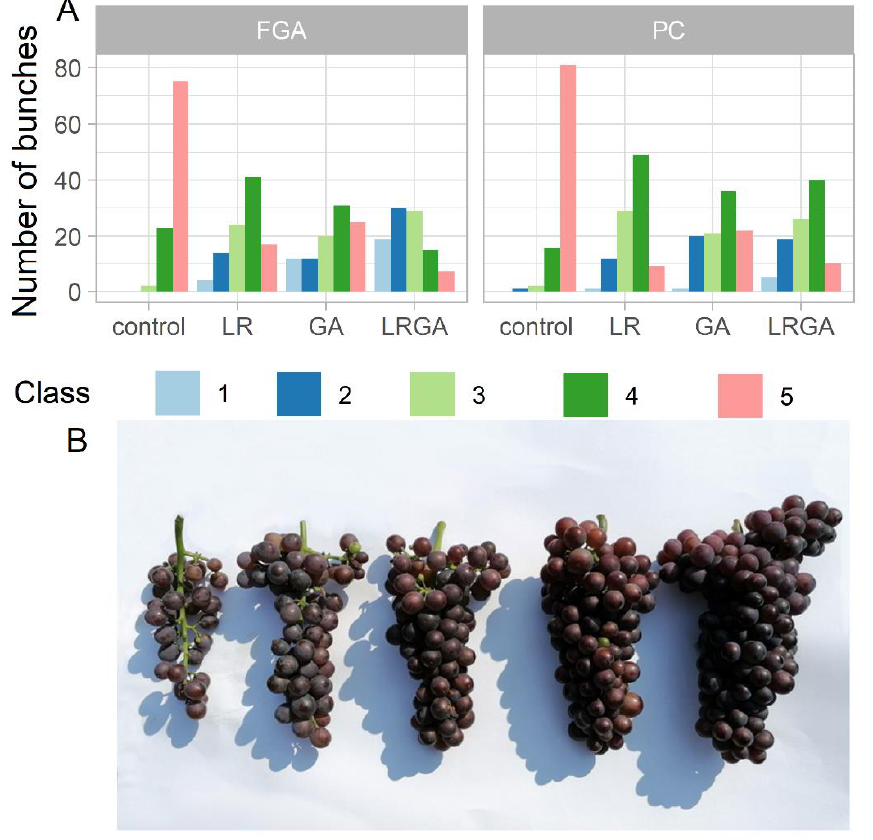
Figure 5. ( A ) Distribution of bunches classes according to [30] assessed at harvest either in FGA and PC vineyard and in control, leaf removal (LR), GA 3 application (GA) and leaf removal plus GA 3 application (LRGA) plants (n = 100 per treatment). Differences between treatments were tested via Z-test with p < 0.001 between control and treated (LR, GA, LRGA) while no significant differences were observed between treated bunches. In ( B ) and example of different bunch classes in relation to compactness and bending capacity of the rachis is shown.